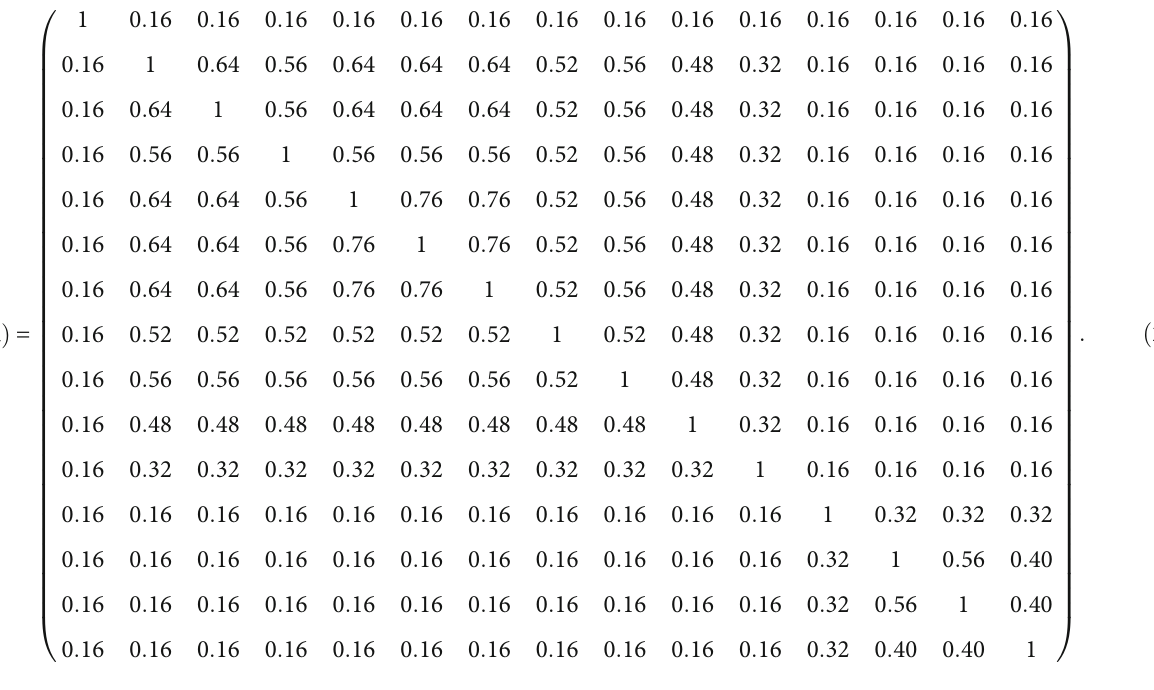
The λ -cut matrices corresponding to λ = 0 : 16, λ = 0 : 32, λ = 1 are calculated sequentially, where λ = 0 : 40